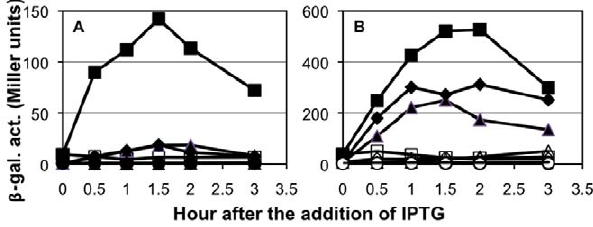
Figure 5. Effect of the A-34T substitution on trxB transcription activated by the wild-type and mutant Spx. Strains carrying trxB- lacZ fusions were grown in DS medium. When the OD 600 was 0.4 to 0.5, each culture was divided into two flasks, and 1 mM IPTG was added to one flask. Samples were taken at time intervals and b -galactosidase activities were measured. (A) Expression of the wild-type trxB- lacZ . Symbols: squares, ORB7276 with Spx DD ; triangles, ORB7282 with Spx DD-R60E ; diamonds, ORB7316 with Spx DD-C10A ; circles, ORB7337 with Spx DD-G52R . (B) Expression of trxB (A-34T)- lacZ . Symbols: squares, ORB7342 with Spx DD ; triangles, ORB7343 with Spx DD-R60E ; diamonds, ORB7347 with Spx DD-C10A ; circles, ORB7348 with Spx DD-G52R . Open symbols represent cells cultured without IPTG and closed symbols represent cells cultured with IPTG.